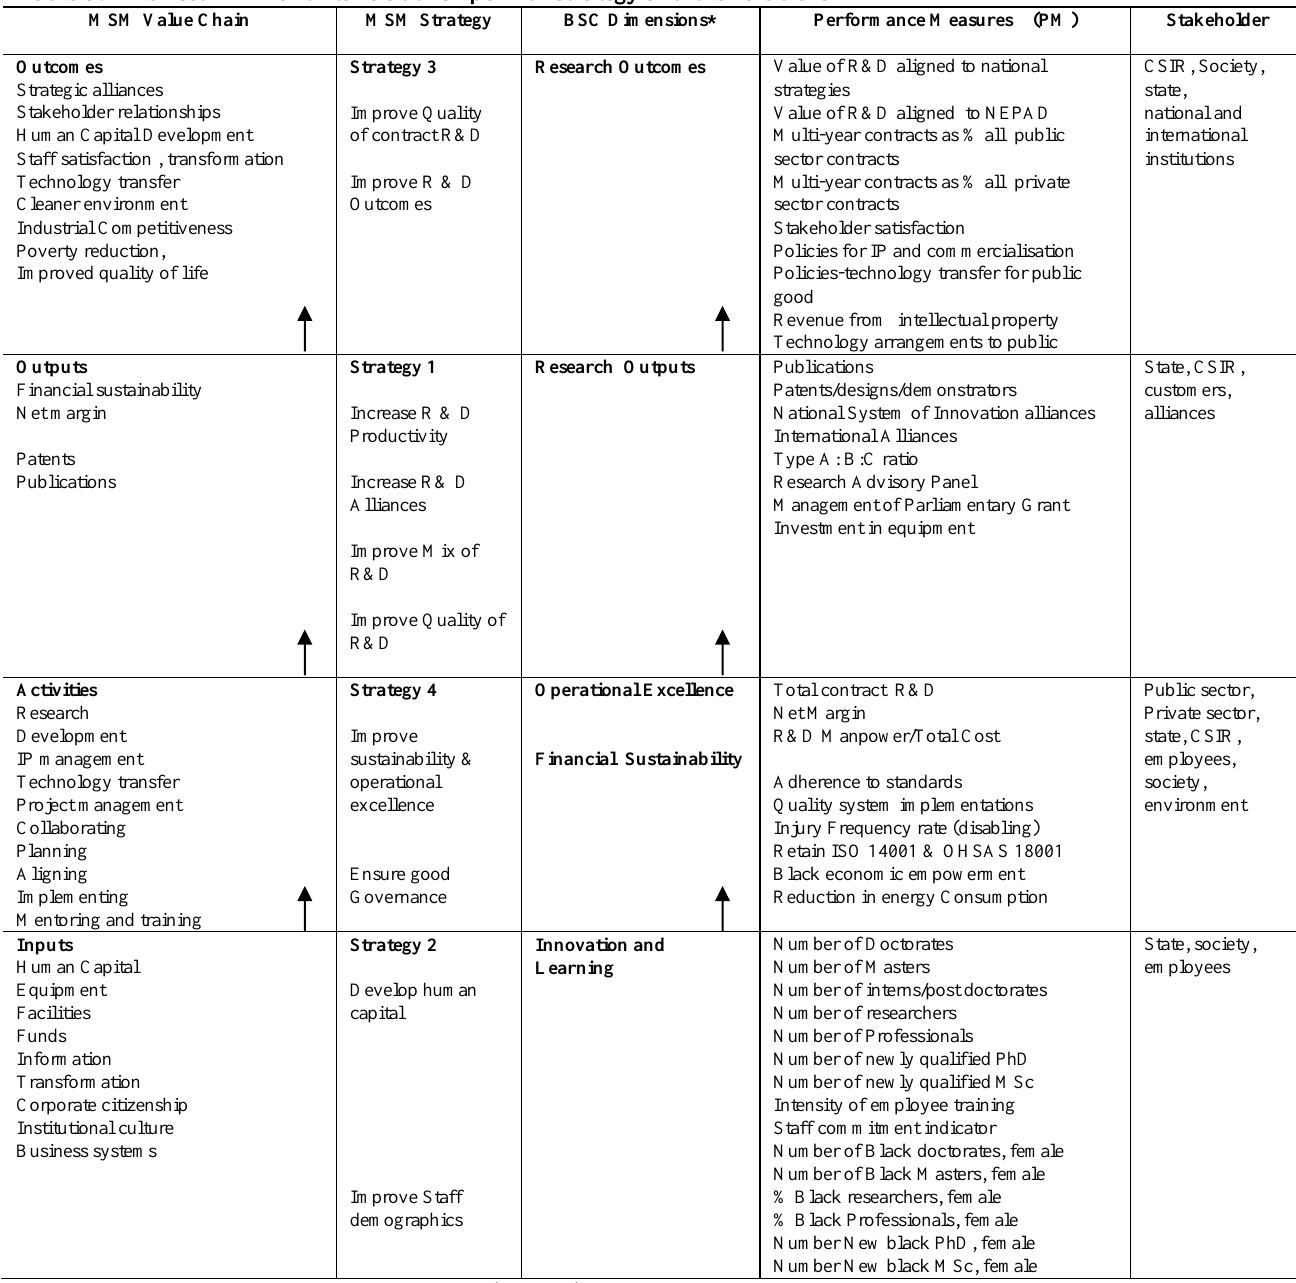
Table 3: A revised PMF and its relationships with strategy and the value